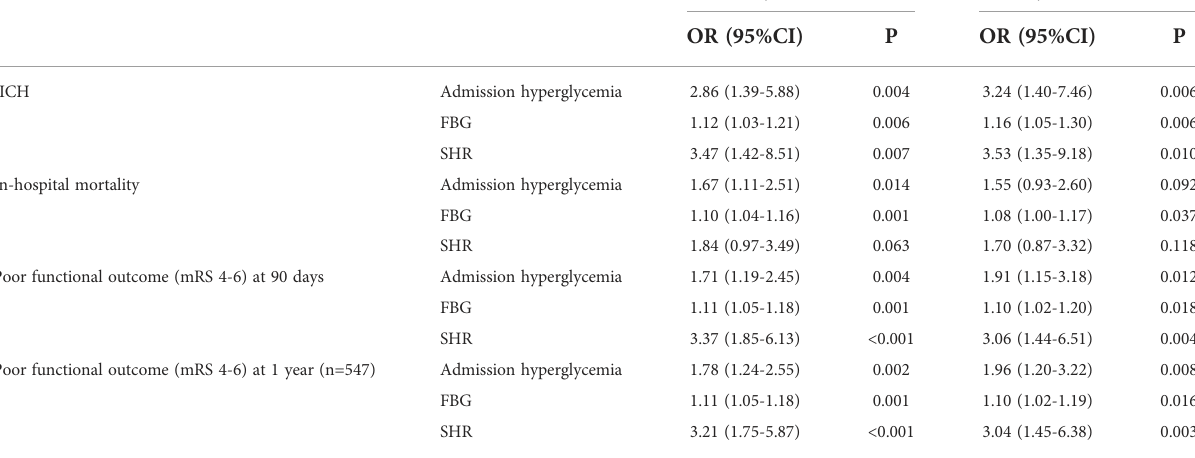
TABLE 2 The associations between perioperative glucose levels and